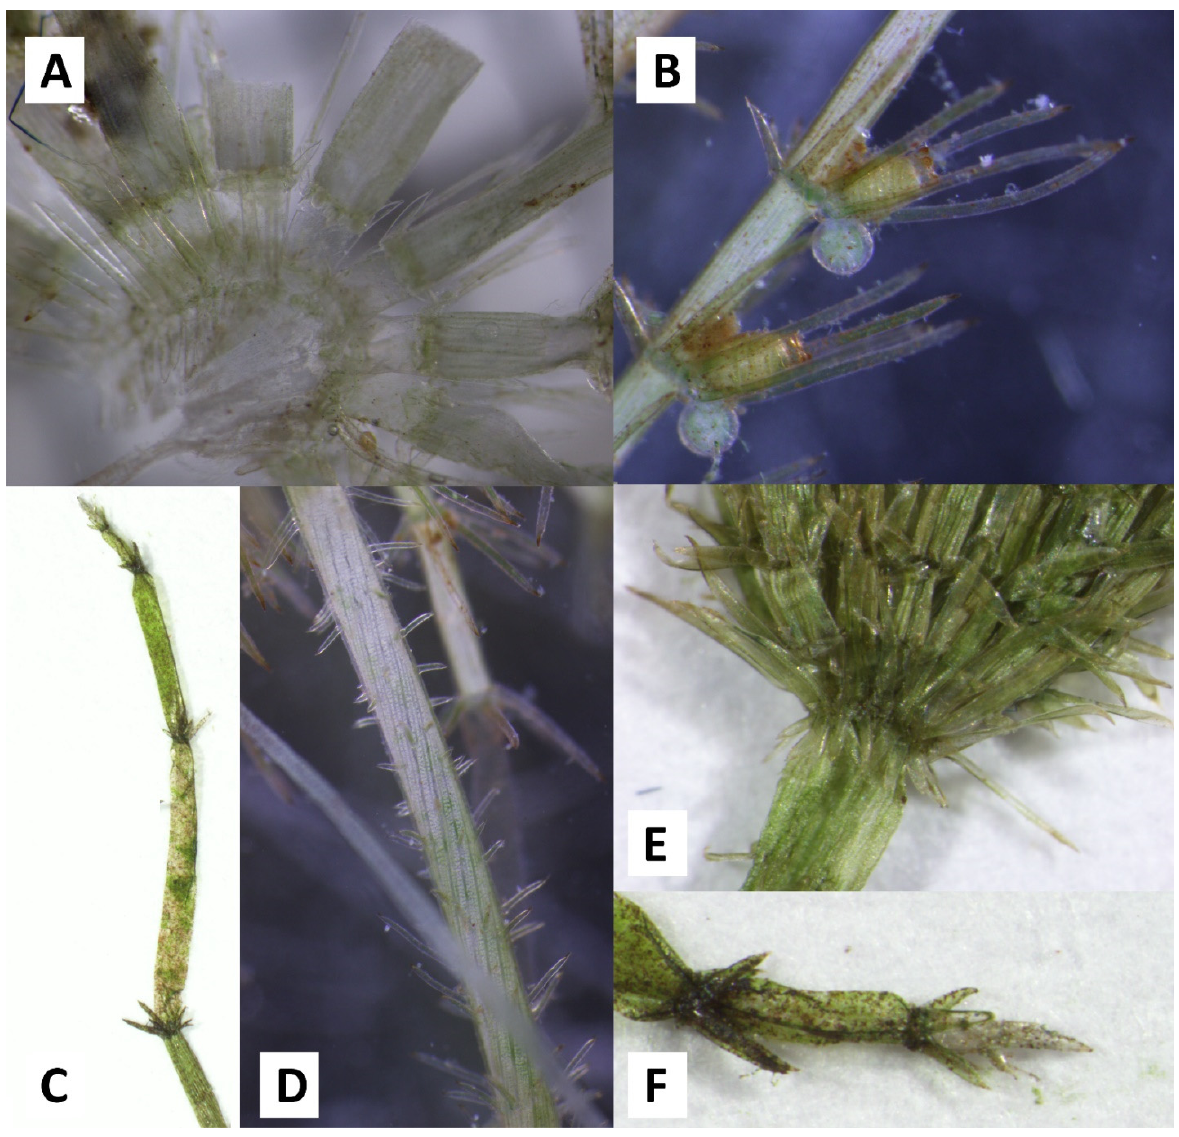
Figure 2. Detailed photographs of C. zeylanica collected at Cala Fuili, Sardinia. ( A ) branchlet whorl with ecorticated basal segments; ( B ) conjoined gametangia; ( C ) ecorticated end segments with bract cells; ( D ) triplostichous main axis cortication with single spines; ( E ) diplostephanous stipulodes; ( F ) branchlet tip cell, surrounded by bract cells.